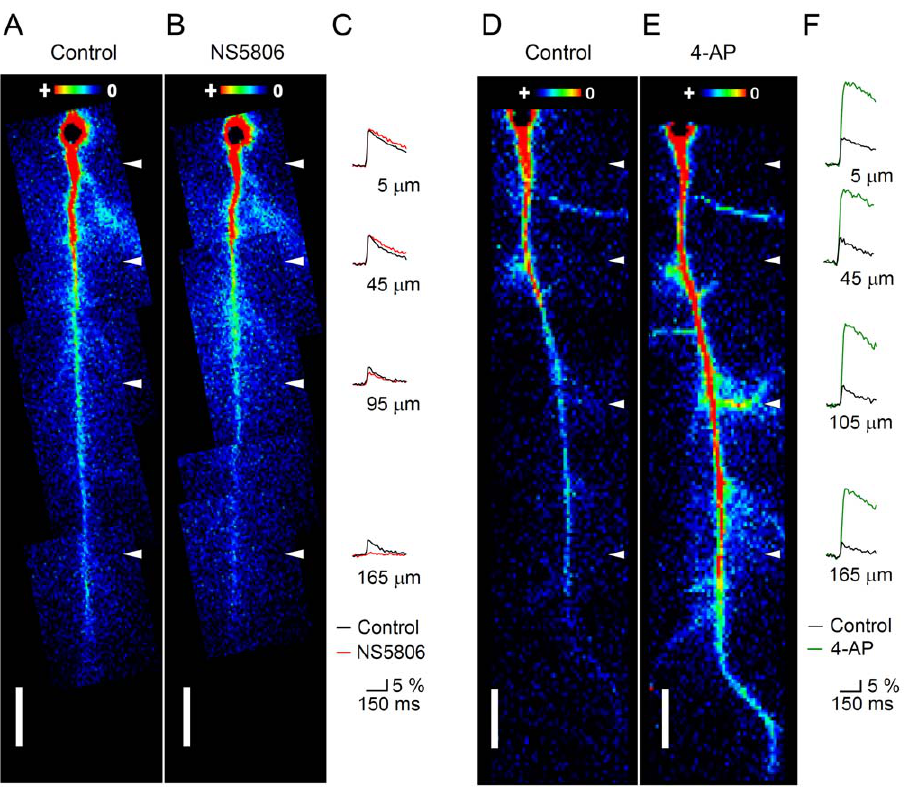
Figure 7. Effect of NS5806 and 4-AP on the dynamics of b-AP-induced Ca 2 + signals. A and B . False color images of a CA1 pyramidal cell from an untreated animal in the absence (Control) and presence of 20 m M NS5806, respectively, during AP backpropagation. The maximal Ca 2 + signal (absolute fluorescence change, D F) caused by the b-AP is color-coded (insets). C . Corresponding Ca 2 + transients ( D F/F in %) recorded at 5, 45, 95 and 165 m m from the soma (see white arrowheads in A and B) in the absence (black traces) and presence of NS5806 (red traces). Note that the Ca 2 + signal at 165 m m from the soma was almost below the detection level in the presence of NS5806. D and E . CA1 pyramidal cell in the absence (Control) and presence of 5 mM 4-AP, respectively, during AP backpropagation. Note that the Ca 2 + signal was still visible in the most distal parts of the apical dendrite and invaded lateral branches in the presence of 4-AP. F . Corresponding Ca 2 + transients recorded at 5, 45, 105 and 165 m m from the soma (see white arrowheads in D and E) in the absence (black traces) and presence of 4-AP (green traces). Note that the Ca 2 + signal showed only little attenuation along the apical dendrite in the presence of 4-AP.